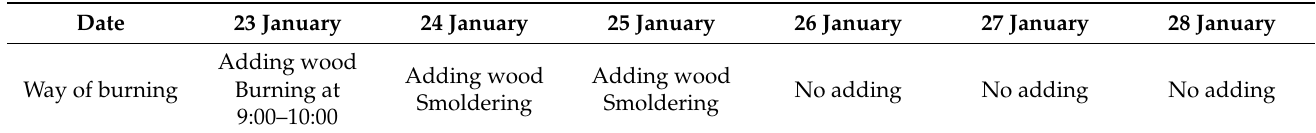
Table 3. The way of burning